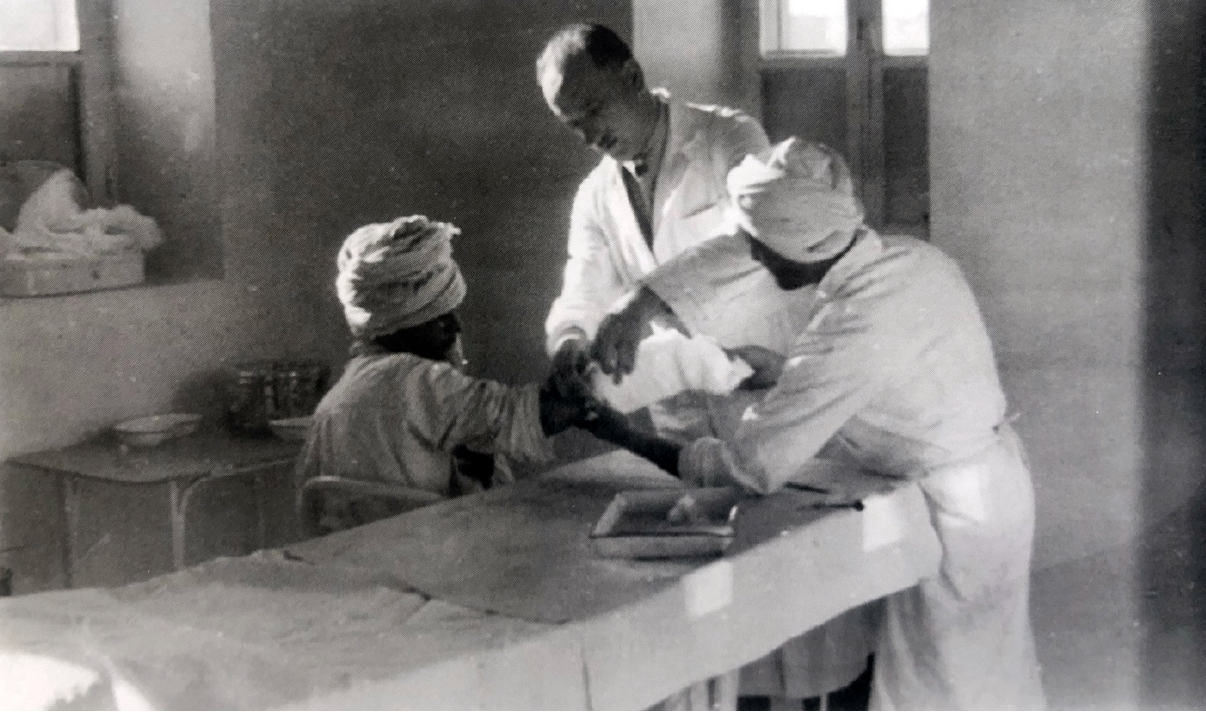
Figure 7. An Egyptian worker receiving medical treatment from an Italian physician and an Egyptian nurse in the hospital. Source: Pellegrini (2011, p.